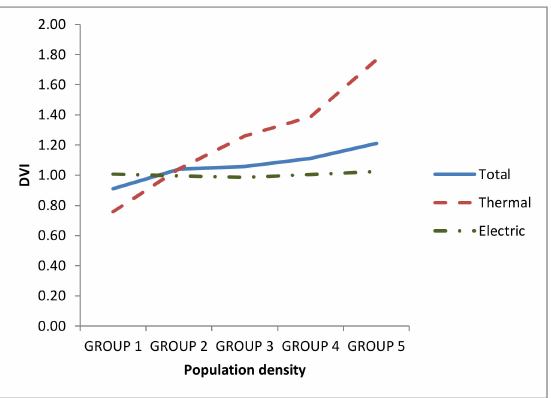
Figure 9. Variation of the DVI index for energy consumptions per household by group of cities without the influence of